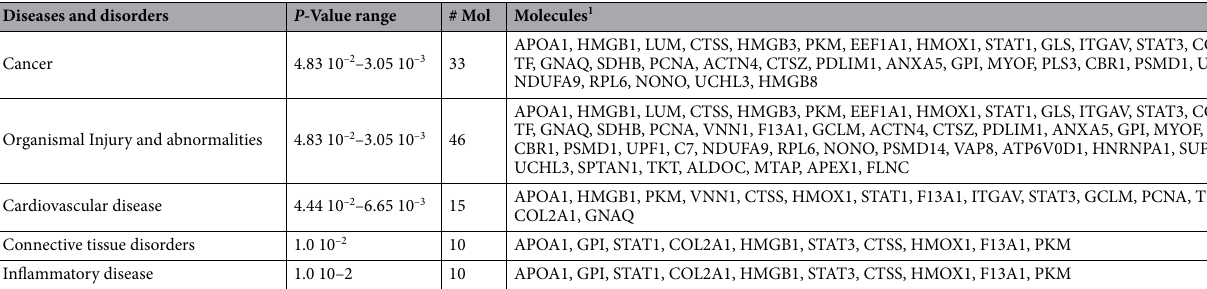
Table 5. Top diseases and disorders for DE proteins in broiler tibiae with BCO. 1 ACTN4, acTinin